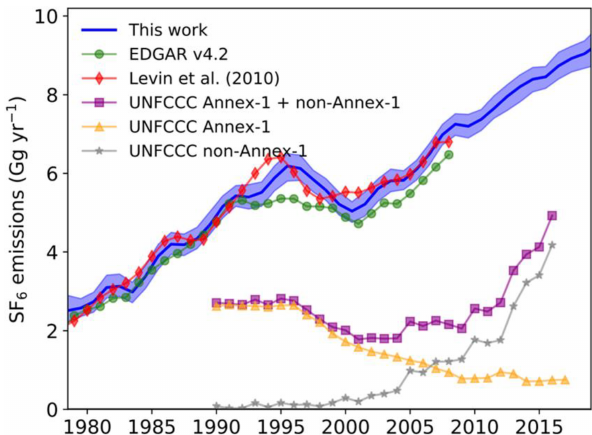
Figure 2. Optimised global SF 6 emissions using AGAGE measure- ments (solid blue line), and the shaded line shows the 1 σ uncertain- ties. Emissions are from Levin et al. (2010, red diamonds), EDGAR 4.2 emissions (green circles), UNFCCC Annex-1 reported emis- sions (orange triangles), UNFCCC non-Annex-1 reported emissions (grey stars), and combined non-Annex-1 and Annex-1 UNFCCC emissions (purple squares).